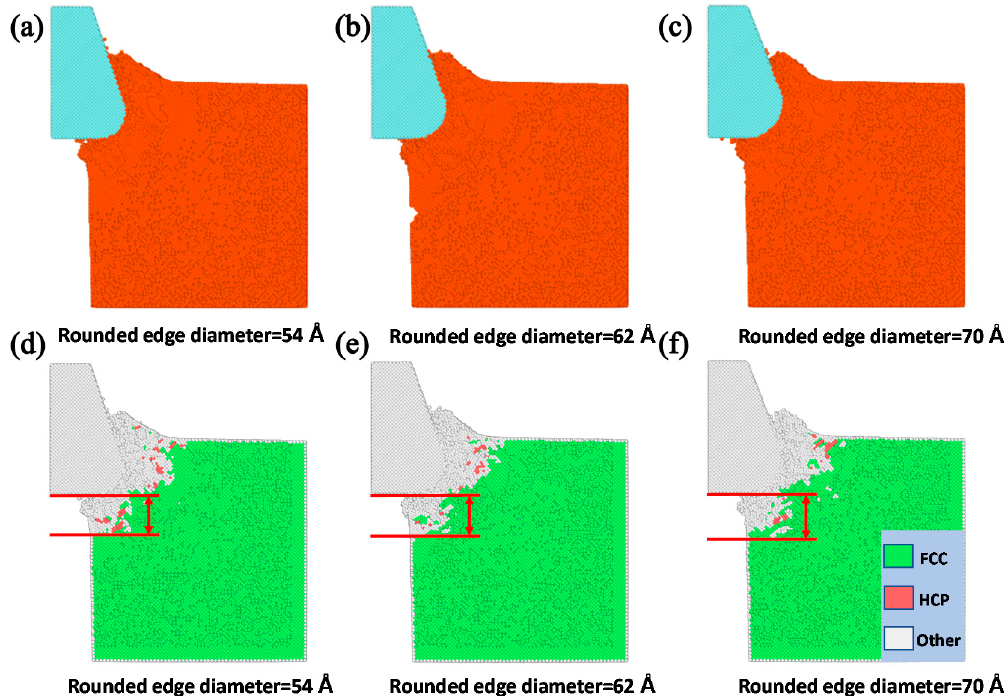
Figure 13. The atomic displacement and lattice distribution in the MD simulation at the 200th load step with varying the tool rounded edge diameter. ( a ) The atomic displacement when the rounded edge diameter = 54 Å; ( b ) the atomic displacement when the rounded edge diameter = 62 Å; ( c ) the atomic displacement when the rounded edge diameter = 70 Å; ( d ) the lattice distribution when the rounded edge diameter = 54 Å; ( e ) the lattice distribution when the rounded edge diameter = 62 Å and ( f ) the lattice distribution when the rounded edge diameter = 70 Å.